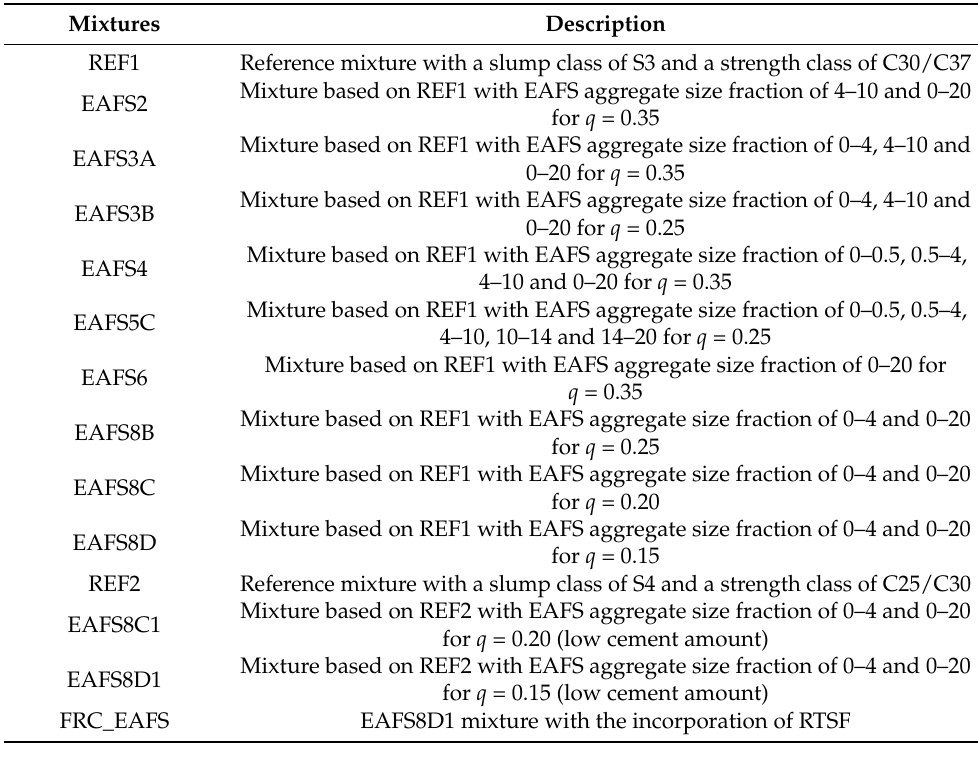
Table 7. Description of the abbreviations adopted to designate the mixtures